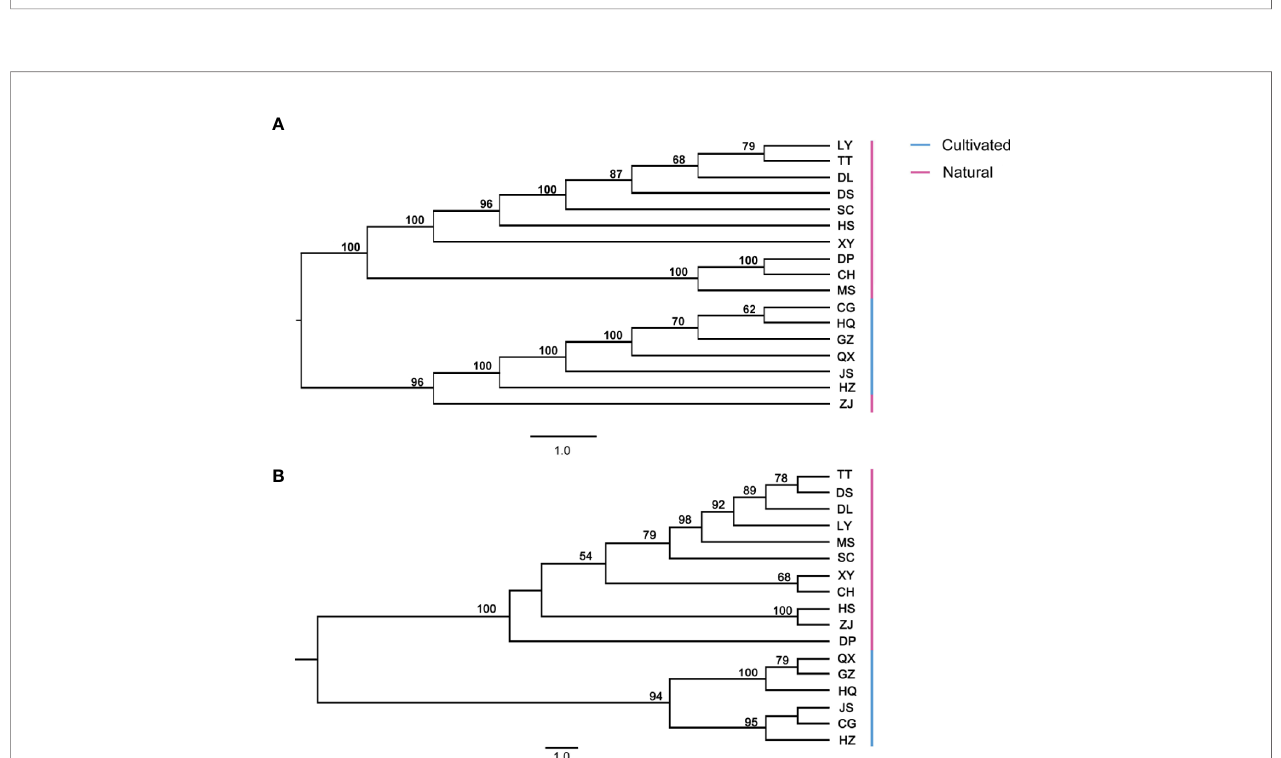
FIGURE 4 | Results of the Neighbor-joining (NJ) analysis for natural and cultivated C. yanhusuo based on the Nei ’ s distance using (A) AFLP and (B) MSAP